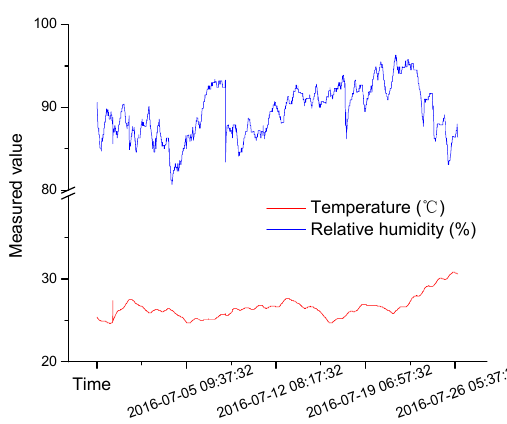
Figure 7. Change curves of temperature and relative humidity in the curing box.